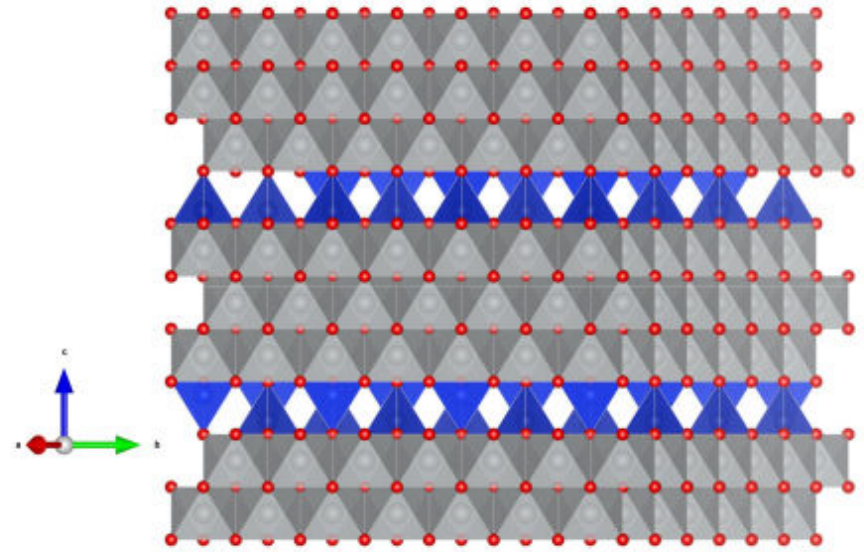
Figure 6. Model of the defect structure: incorporation of tetrahedral Si 2 O 4 layers (blue) between octahedral Ni 4 O 4 layers (grey) in hexagonal